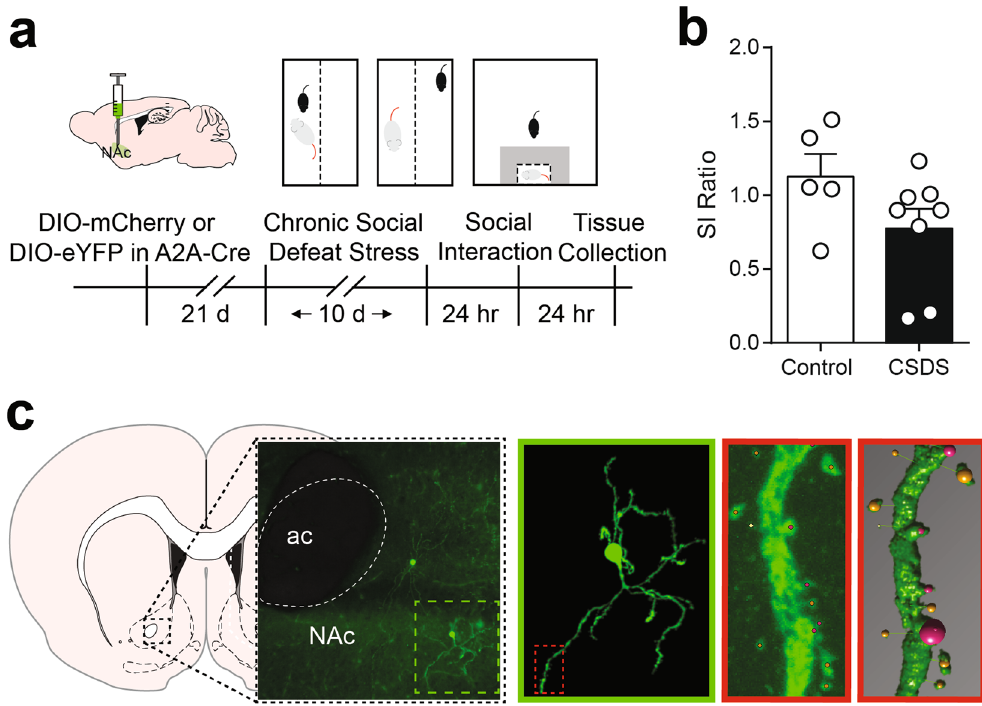
Figure 1. ( a ) Experimental timeline. A2A-Cre mice were injected with AAV-eYFP or AAV-mCherry to label D2-MSNs prior to chronic social defeat stress (CSDS). ( b ) Social interaction behavior after 10 days CSDS or in unstressed controls. Data points represent individual mice. ( c ) Representative image of sparsely labeled MSNs in the NAc and schematic for dendritic spine analysis workflow. Secondary dendrites of single D2-MSNs are imaged at 63x, then analyzed in Neuron Studio. Identified spines are confirmed in 3D reconstructed